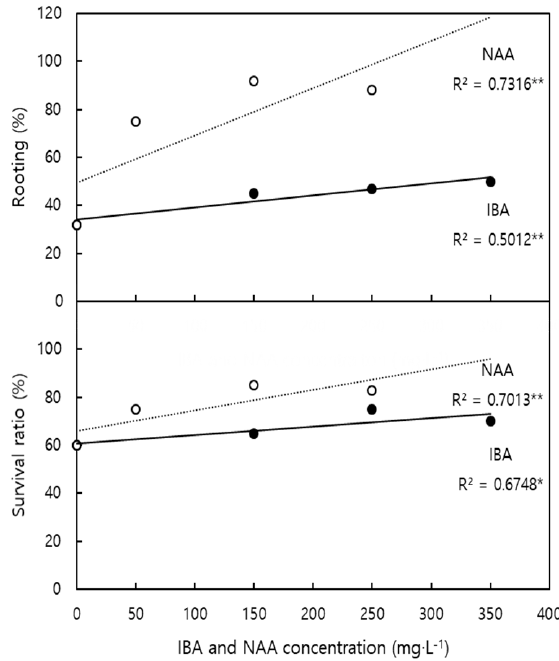
Figure 3. Correlation between rooting (top), survival ratio (bottom), and IBA and NAA concentrations of Rhododendron micranthum Turcz. ● and ○ denote IBA and NAA, respectively; * and ** denote significant at p ≤ 0.05 and 0.01, respectively (n = 30).